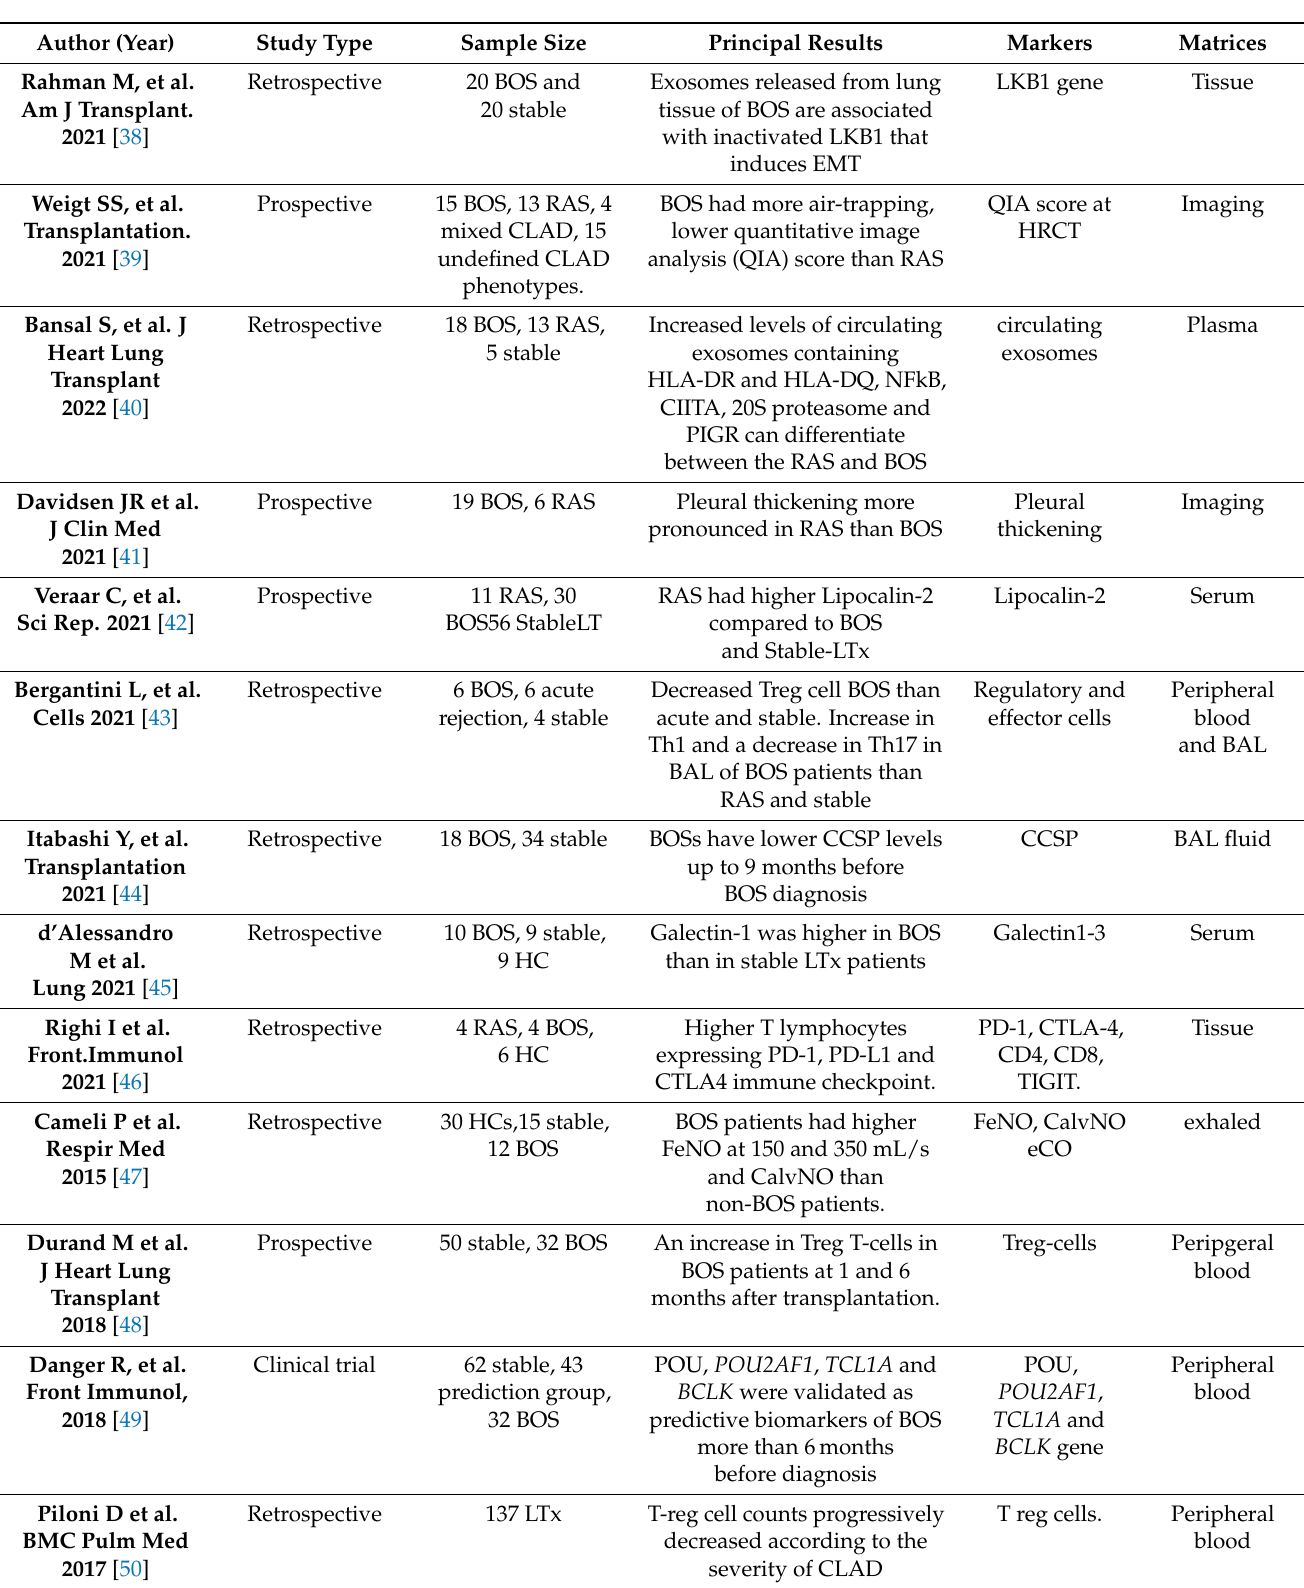
Table 1. Characteristics of the selected